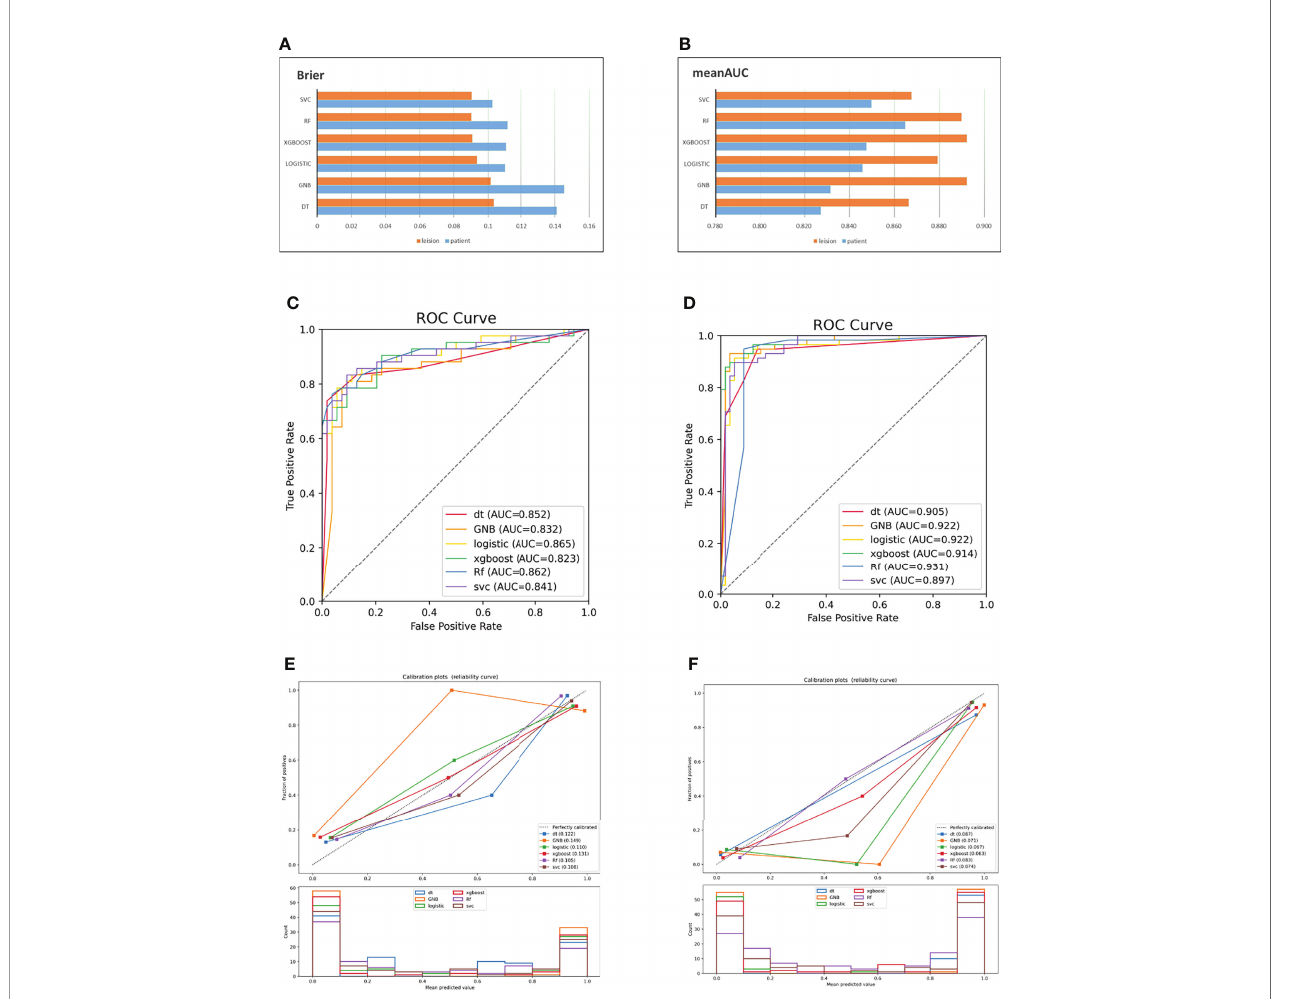
FIGURE 3 | AUC and Brier score of the combined model based on two data sets (A, B) ; ROC curve of the combined model based on patients (C) ; ROC curve of the combined model based on lesions (D) ; combined model calibration curve based on patients (E) ; combined model calibration curve based on lesions (F)